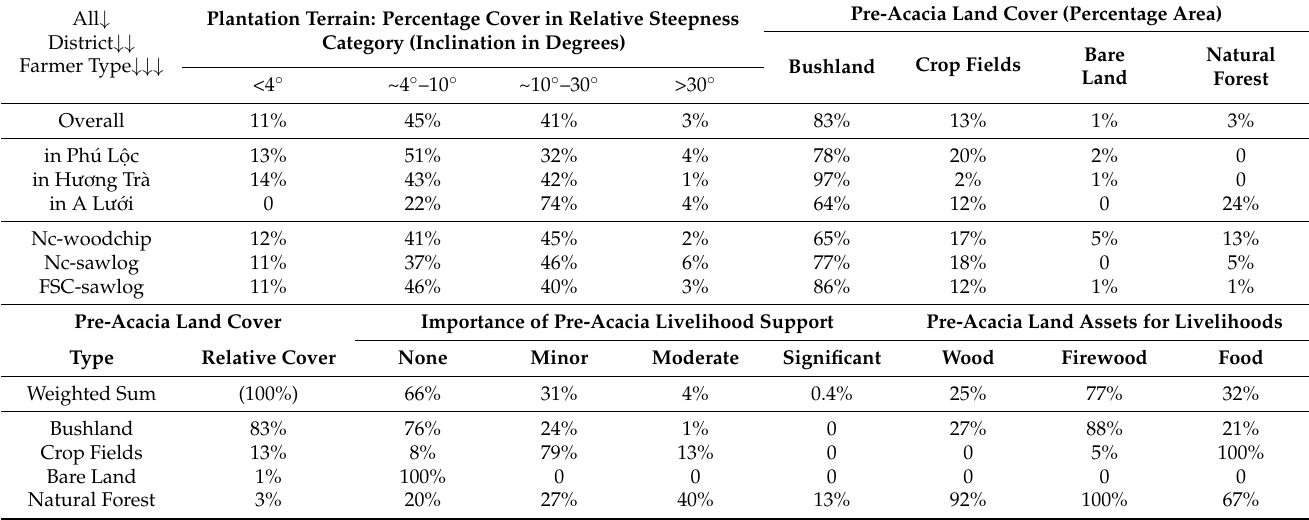
Table 4. Summary of data on the plantation terrain and pre-acacia land cover/use, showing differences among the three study districts and farmer